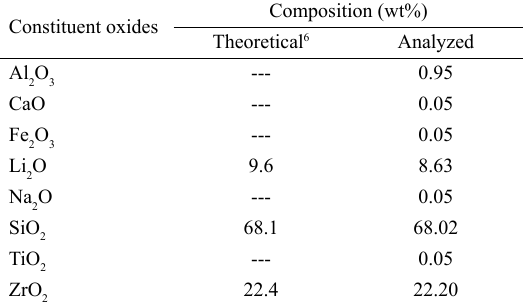
Table 1. Chemical composition of the LZS parent glass.